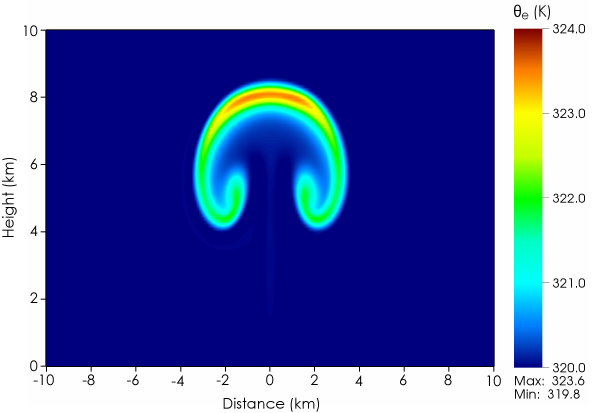
Figure 11. Equivalent potential temperature field for the moist rising bubble test case with background wind of U = 20 ms − 1 . Snapshot taken at t = 1000 s simulation time.